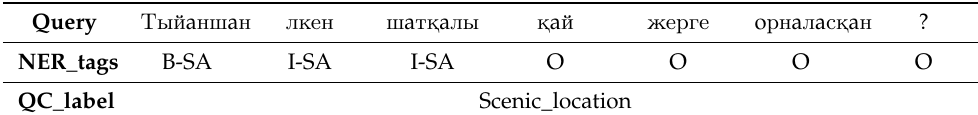
Table 1. An example sentence from KQU